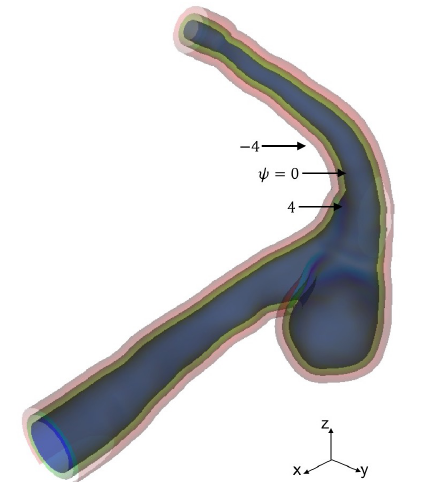
Figure 4. Level set function for aneurysm surface